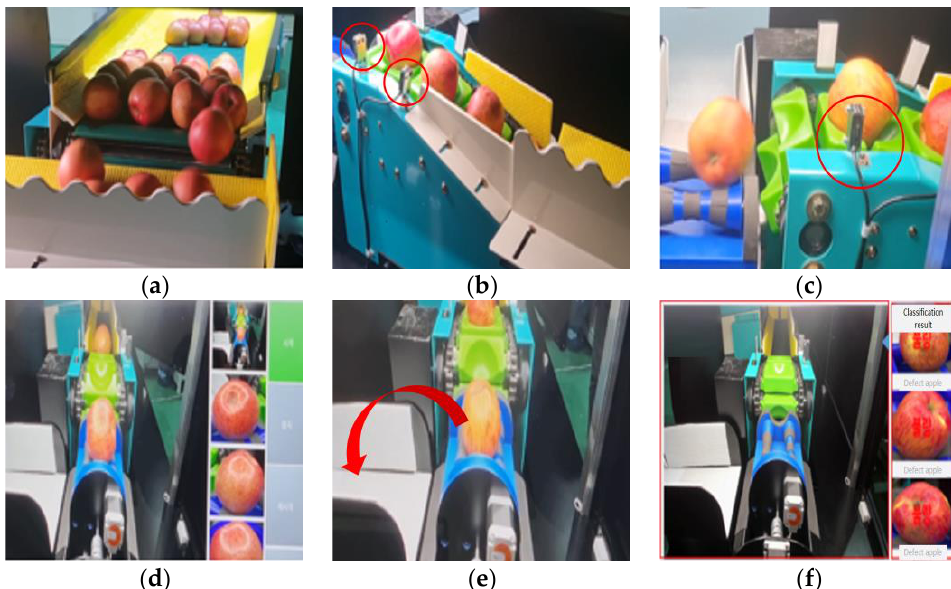
Figure 1. The process of the apple sorting system: ( a ) apple supply conveyor; ( b ) transfer conveyor belt; ( c ) object detection sensor; ( d ) processing of CNN classifier; ( e ) stepping motor; ( f ) monitoring of classifier result.